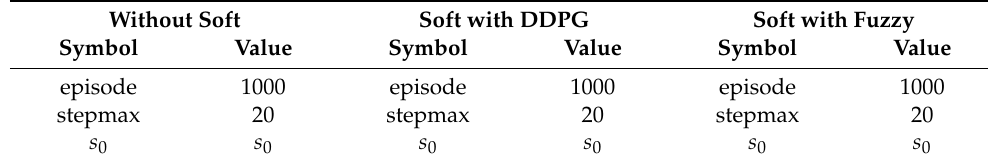
Table 4. Training parameter setting of each